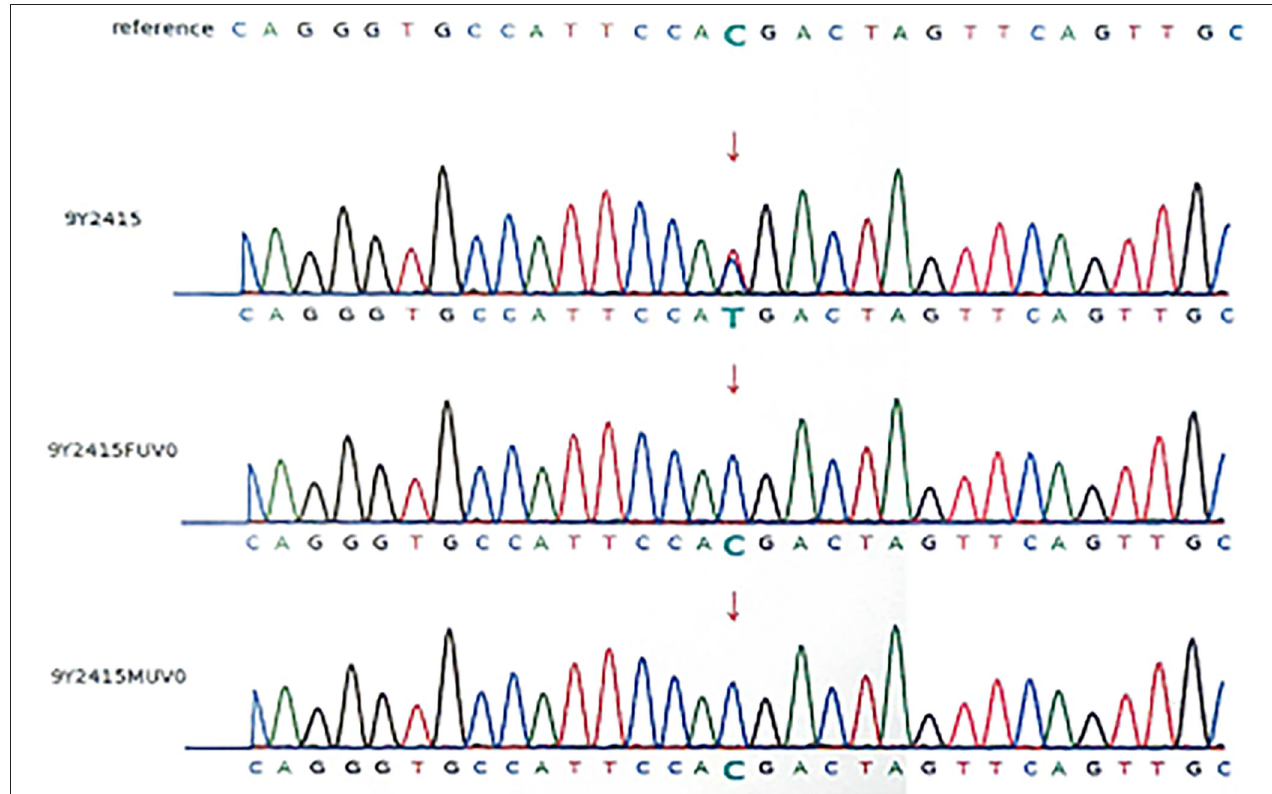
FIGURE 2 | DNA electrophoregram with the c.1603C > T,p.R535X mutation in exon 10 of CTNNB 1. 9Y2415:patient; 9Y2415FUVO:father;